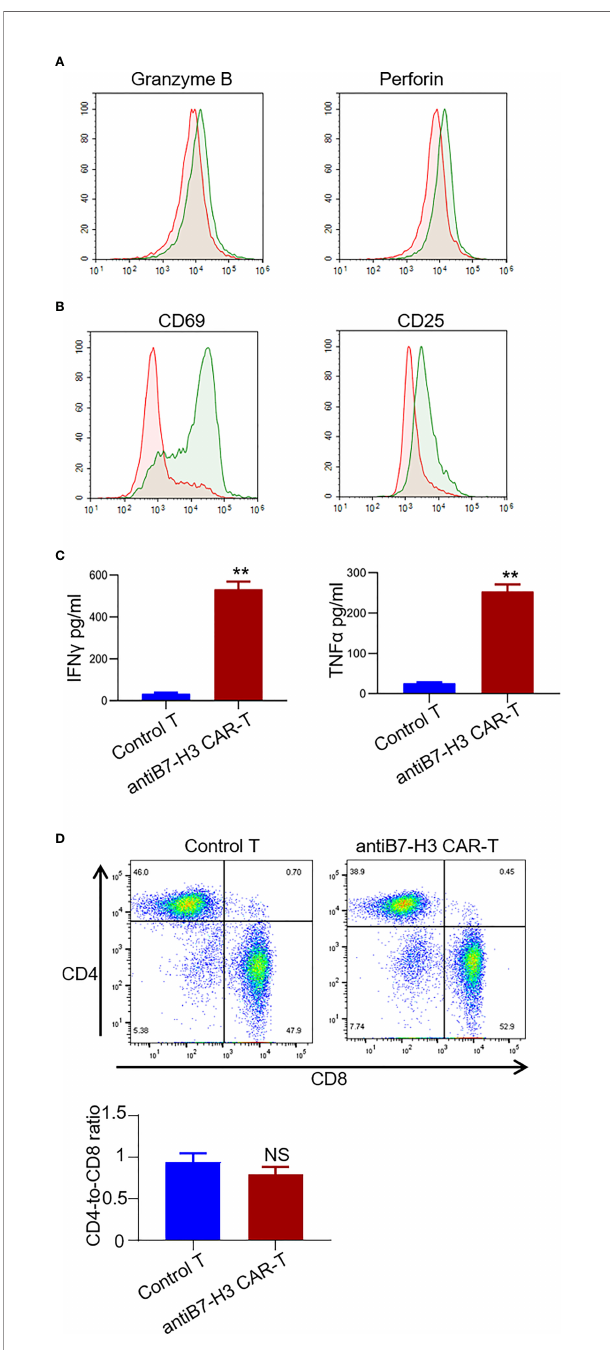
FIGURE 4 | Characterization of B7-H3-retargetedCAR-T cells after co-cultured with chordoma cells. Forty-eight hours after co-culture of B7-H3-retargeted CAR-T cells with B7-H3 positive chordoma cells at a 2:1 E:T ratio, cells were subjected to FACS examination. (A) Secretion of Granzyme B and perforin from CD3 positive T cells was detected by FACS assay. (B) Up-regulation of activation markers CD69 and CD25 in CD3 positive T cells. (C) Concentrations of IFN g and TNF a in the supernatants were measured by ELISA. **p < 0.01. (D) The phenotype analysis of CAR-T cells. 14 days after lentivirus CAR transduction, T cells were collected and stained with CD4-PE QA18A35 (Biolegend) and CD8-FITC SK1 (Biolegend), followed by FACS analysis. NS, not signi fi